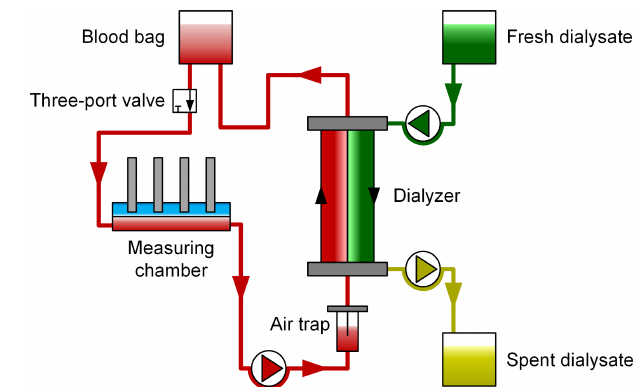
Figure 5. Continuously measured sodium concentration using the calibrated ISEs (solid blue line) compared to the blood gas analyzer (BGA) as a reference (red